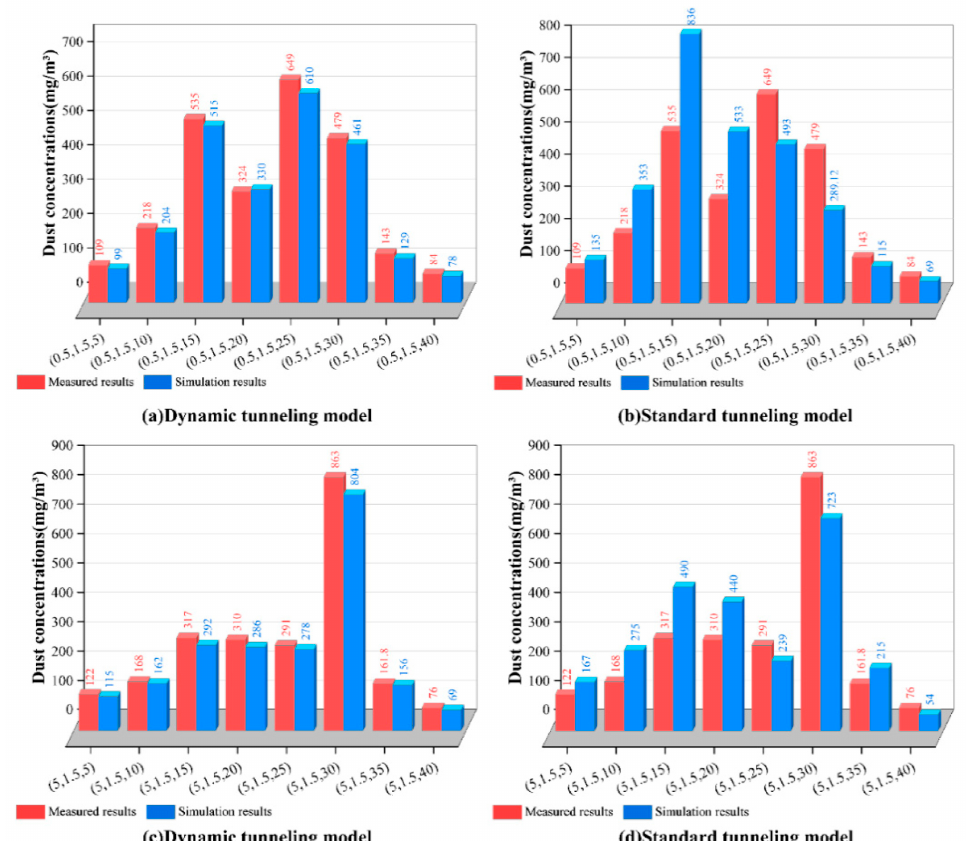
Figure 21. Comparison of the simulation results at several measuring points with the measured dust concentration.